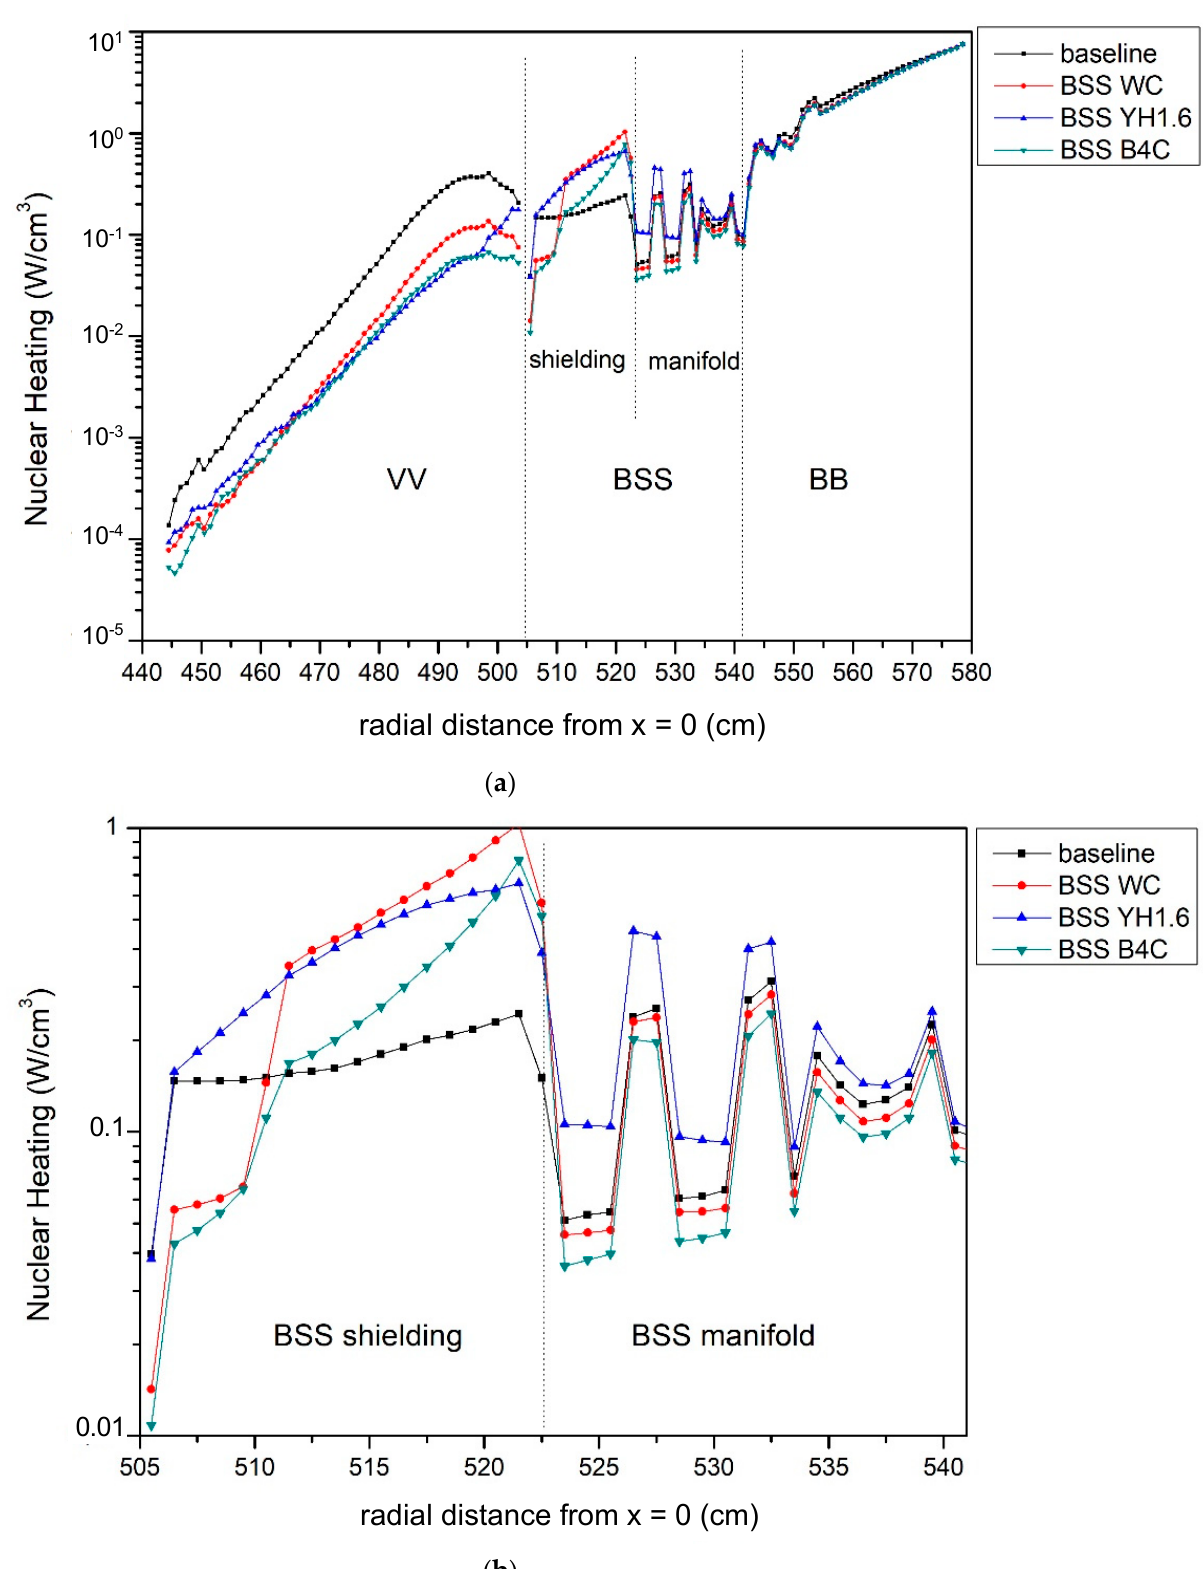
Figure 3. Nuclear heating radial profile at the IB equatorial plane from the FW to the VV ( a ) and just for the BSS ( b ) for the baseline model and the 3 shielding proposals.